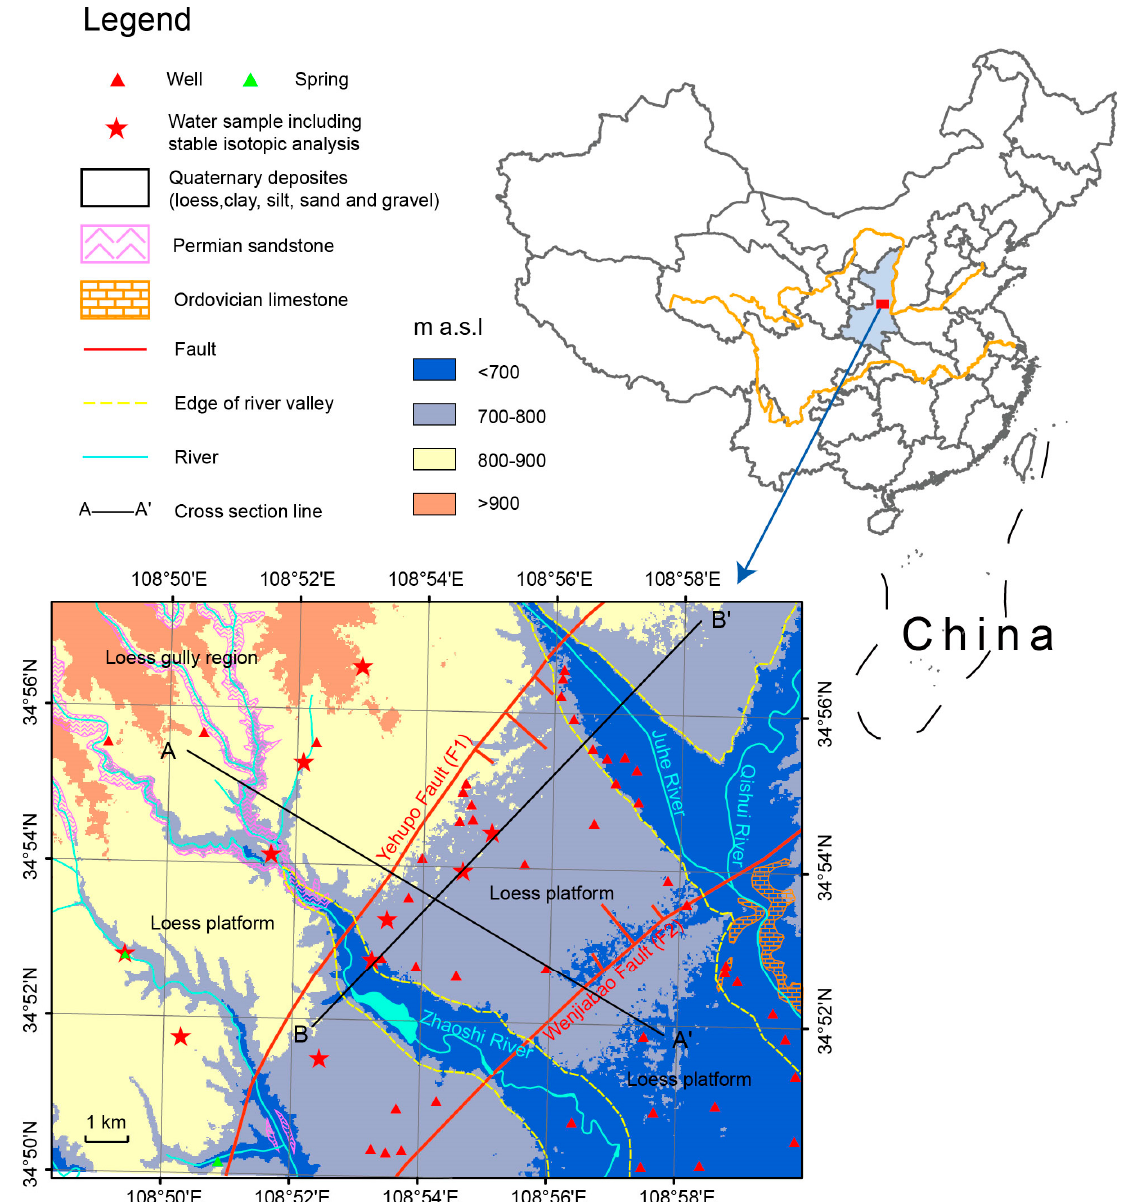
Figure 1. Map showing the location of the study area.